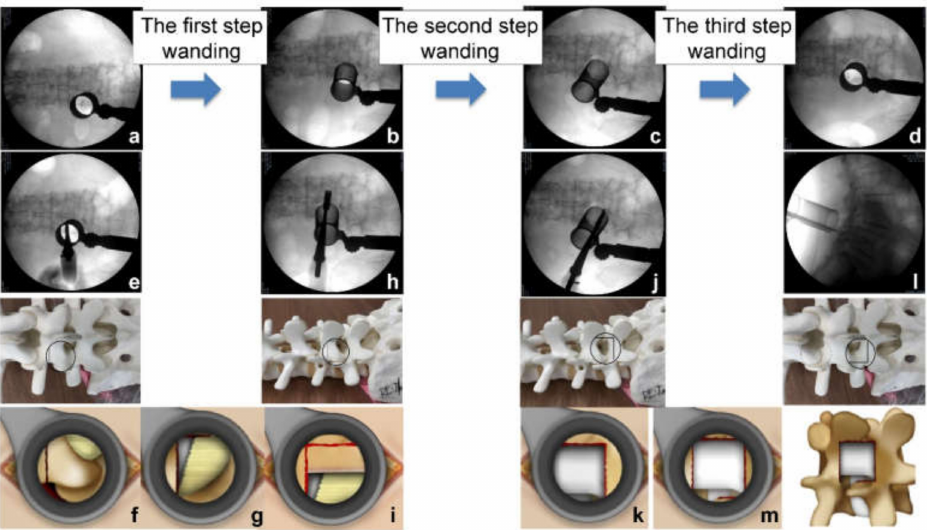
Figure 1. Posterior oblique square decompression with three-step wanding technique. ( a ) Tubular retractor insertion. ( b ) The first wanding to the opposite side. ( c ) The second wanding to the caudal side. ( d ) The third wanding. ( e , f ) The inferior articular process and pars interarticularis resection. ( g ) The identification of the flavum tip and the dura. ( h , i ) The opposite side decompression. ( j ) The cranial part of inferior vertebra resection. ( k ) The remaining flavum resection. ( l ) The L-shaped excision on the superior articular process of the caudal vertebra. ( m ) Completion of posterior oblique square